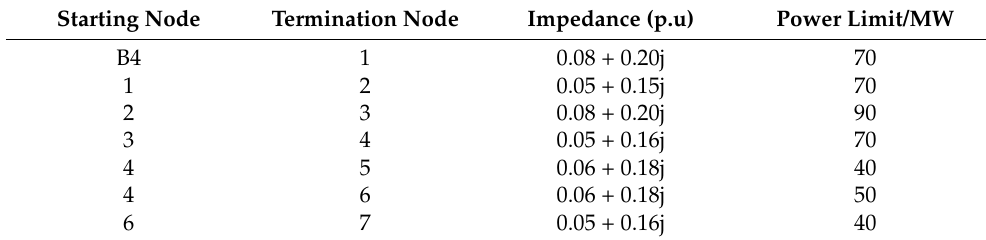
Table 4. Distribution network 2 parameters.